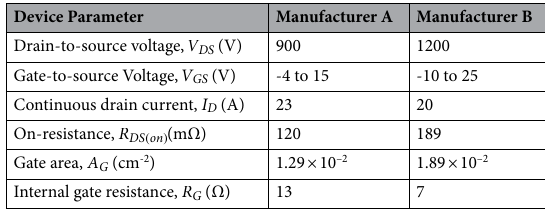
Table 1. Device parameters of measured SiC MOSFETs.